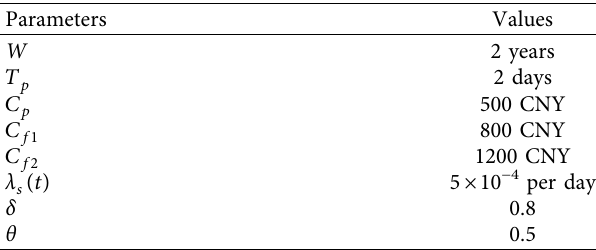
Table 2: The values of parameters in the presented numerical